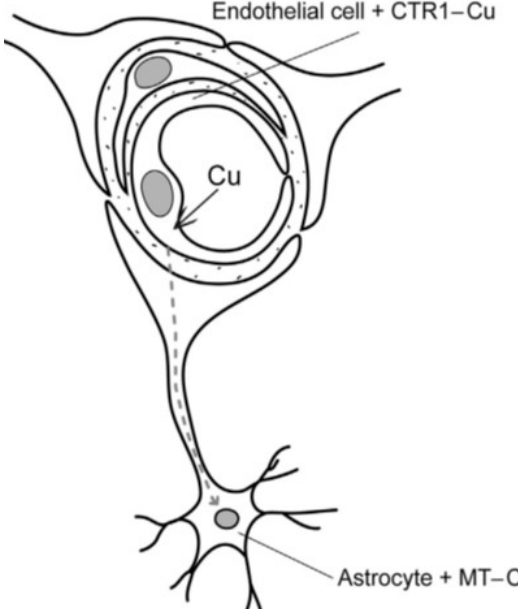
Figure 1. Blood–brain barrier (neurovascular unit) in North Ronaldsay sheep. Copper is taken up by transporter CTR1 in brain capillary endothelial cell and transferred across abluminal membrane to enter the astrocyte where it is bound to metallothionein (MT) as copper-MT. (Reproduced with permission from Haywood, J. Comp. Path.; published by Elsevier Ltd, 2013) .